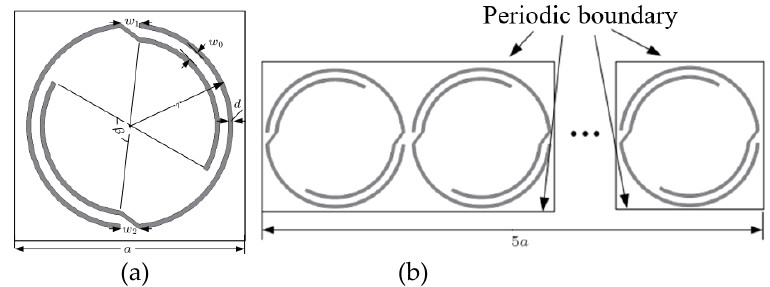
Figure 9. The schematic diagram of the double-opening Helmholtz periodic structure: ( a ) The unit structure’s cross section of the double-split Helmholtz resonant structure; ( b ) The finite structure with 5 cells of the double-split Helmholtz resonant structure [39].